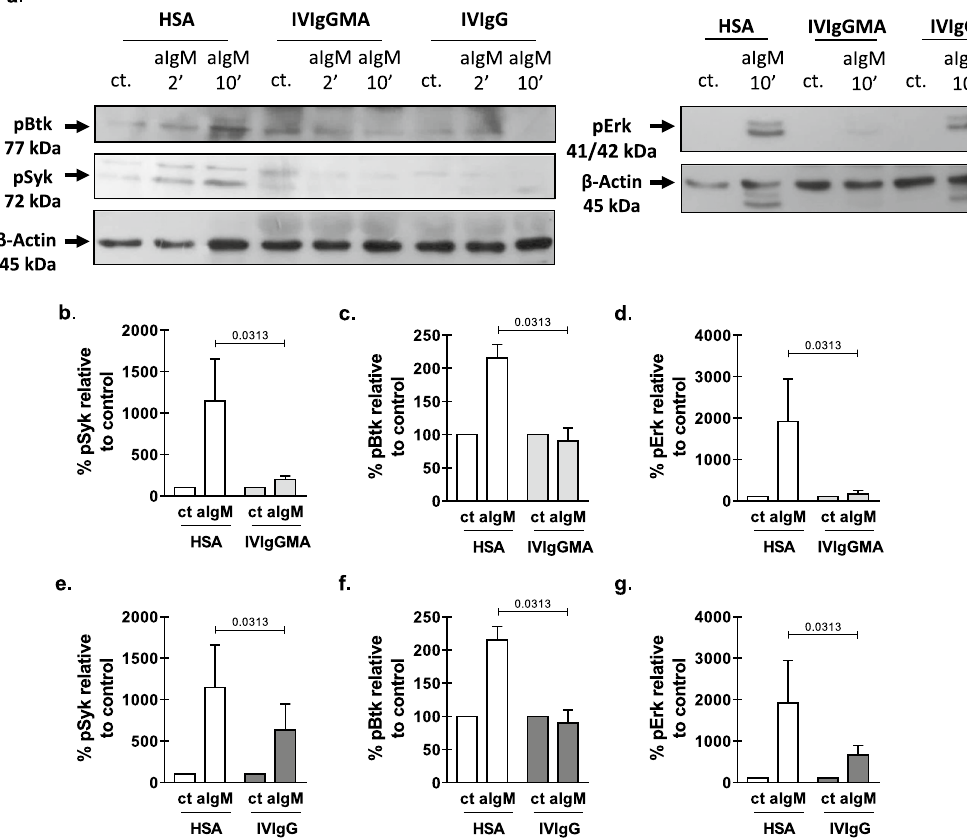
Figure 4. Effect of IVIg preparations on BCR signaling pathway. Purified B-CLL cells (1 × 10 6 cells) were incubated with IVIgGMA, IVIgG (10 mg/mL of IgG) or HSA and anti-IgM (25 µg/mL) or the corresponding isotype control for 2 or 10 min. Then, cells were lysed and whole cell extracts were prepared as described in Material and Methods. Proteins were separated on a standard 10% SDS-PAGE and transferred to a PVDF membrane. Membranes were probed with primary antibodies for phospho-Syk (pSyk), phospho-Btk (pBtk), phospho-Erk1/2 (pErk) and β-actin, followed by the corresponding secondary antibody as described in Material and methods. Specific bands were visualized by enhanced chemiluminiscence (ECL) method. ( a ) Western blot analysis of pBtk, pSyk and pErk1/2 protein levels. β-actin was included as loading control. Cropped western blot images are shown, full-length blots are presented in Supplementary Fig. S7 and S8 online. Black arrow indicates the specific band. ( b–g ) Quantitative densitometry protein expression relative to β-actin (loading control) is shown. Results are shown as the % of protein expression in activated condition relative to each control condition. The mean ± SEM is shown. Statistical analysis was performed using the Wilcoxon test. n = 5, p < 0.05 was considered